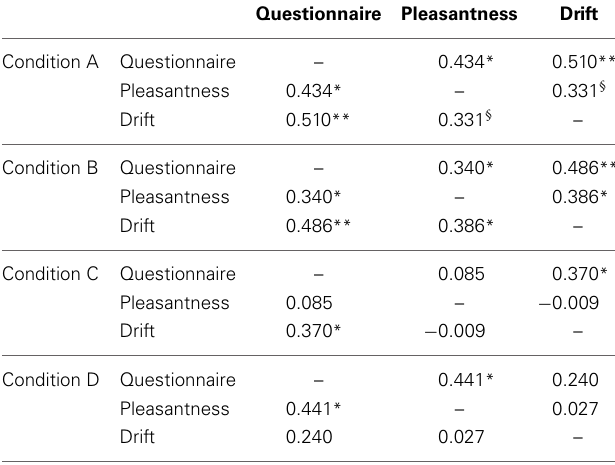
Table 3 | Pearson product-moment correlation matrix among experimental conditions (A, slow stroking to back of hand; B, fast stroking to back of hand; C, slow stroking to palm of hand and D, fast stroking to palm of hand) and self-report measures of illusion strength (measured by response to the questionnaire statements), rated pleasantness of touch and proprioceptive drift